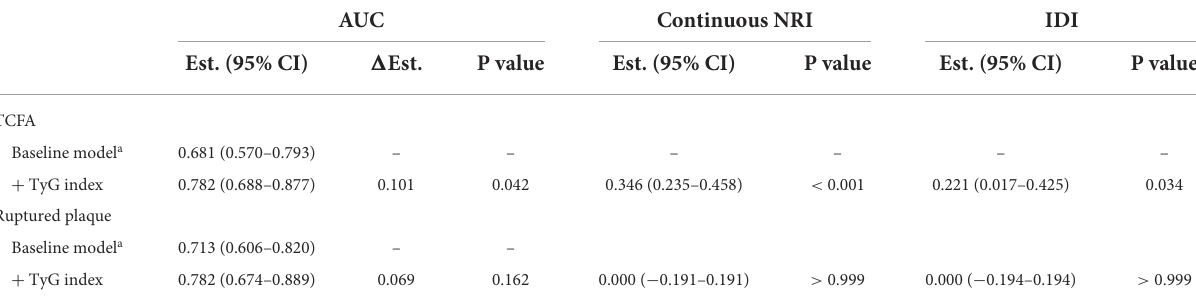
TABLE 6 Incremental ability of TyG index on the predictive performance for non-culprit TCFA and ruptured plaque beyond classical risk